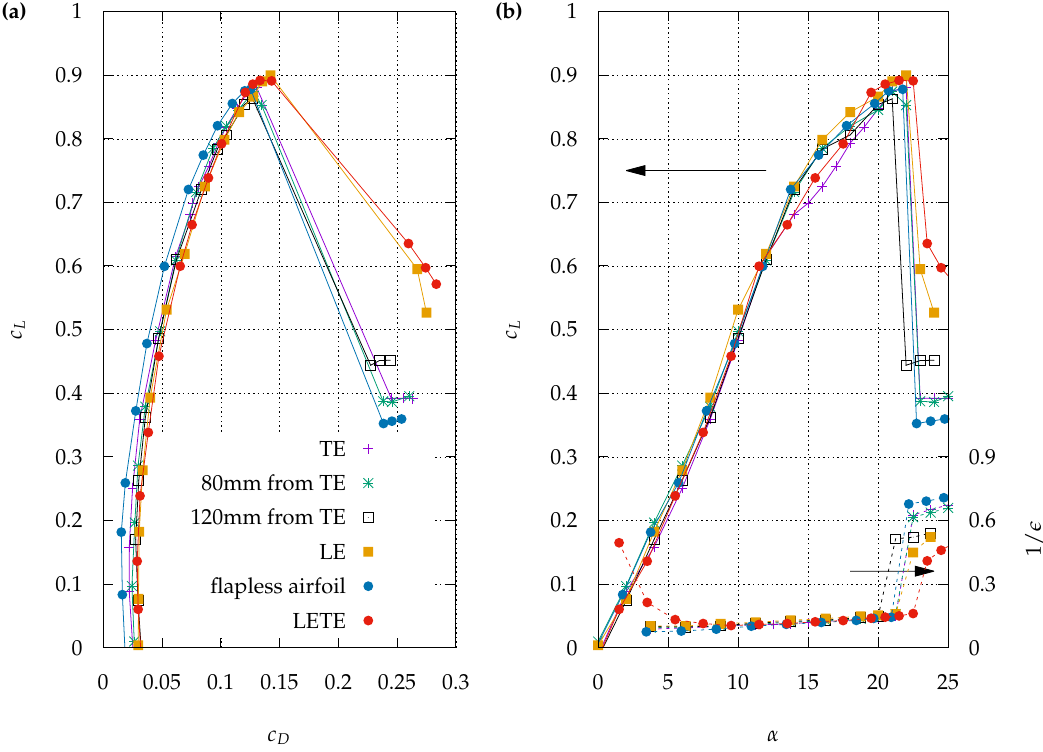
Figure 7. ( a ) Lift coefficient over drag coefficient; ( b ) lift coefficient and lift-to-drag ratio as a function of the angle of attack; LE refers to leading edge, TE to trailing edge, and LETE for the combination of the leading and trailing edges; the arrows in ( b ) indicate the ordinates of the